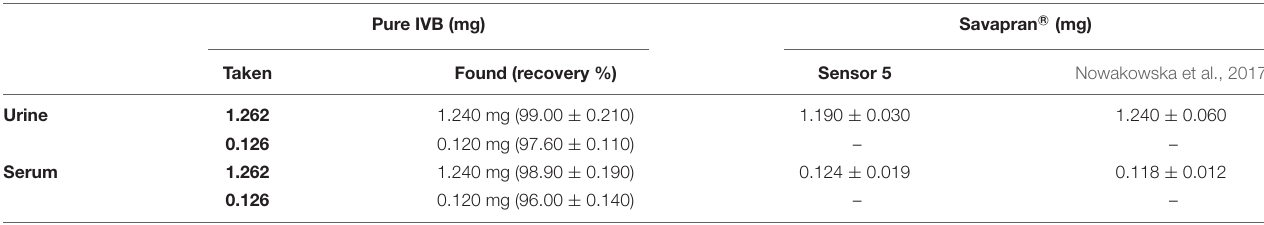
TABLE 4 | Comparison between the response characteristics of the best electrode (sensor 5) of this work, with early reported sensors.